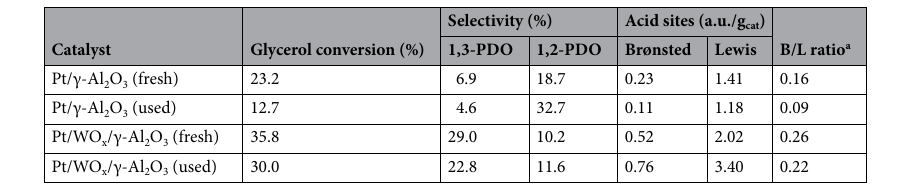
Table 2. Catalytic performance and acidity of catalysts by FTIR. a Proportional concentration of Brønsted and Lewis acid